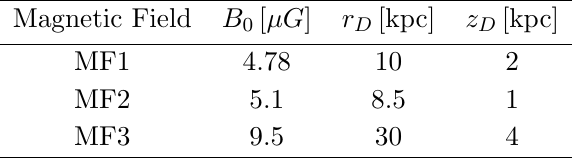
Table 3 . Parameters for the magnetic (cid:12)eld parameterisation of eq. (6.5).